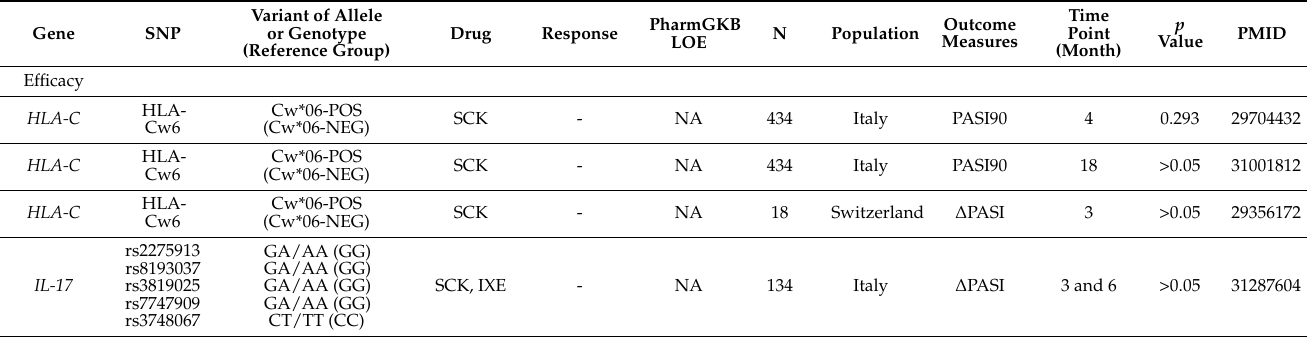
Table 6. Genetic polymorphisms associated with response of IL-17 antagonist in patients with